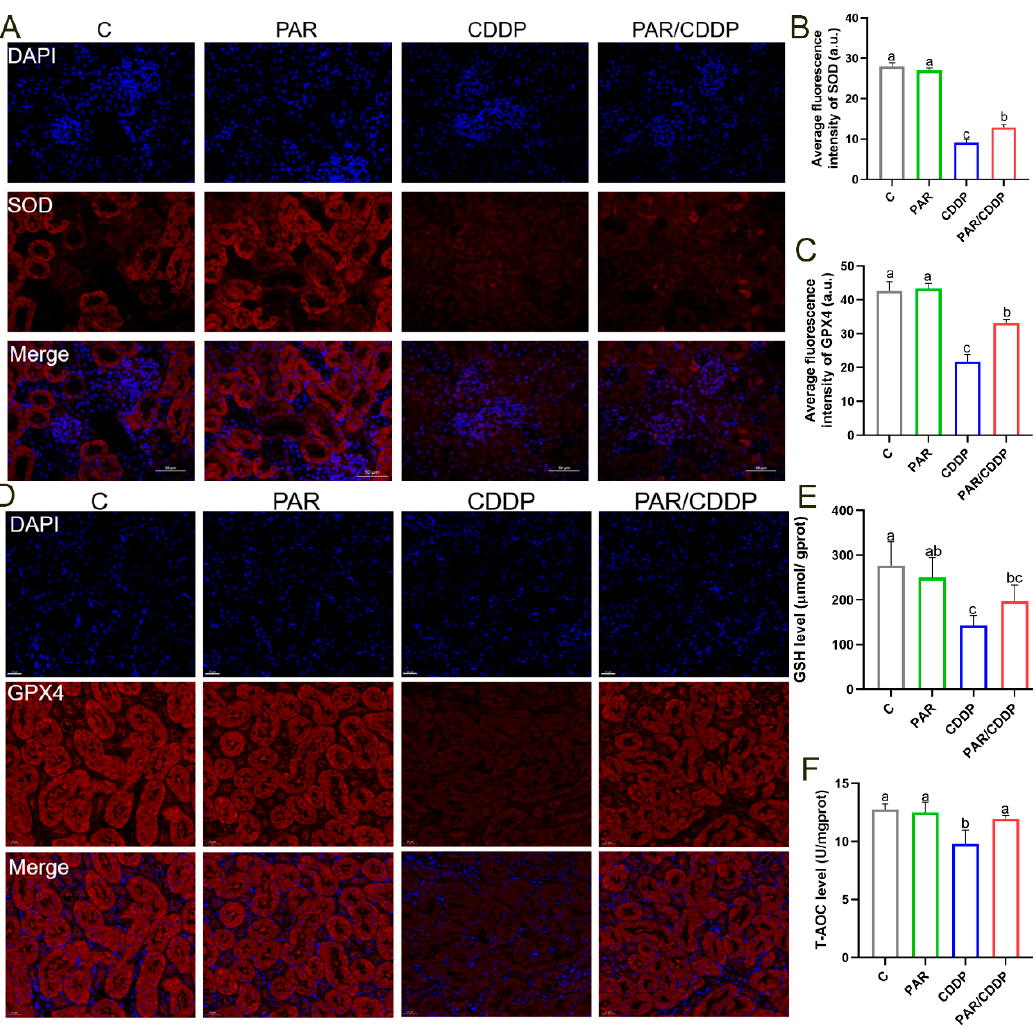
Figure 3. Effect of paricalcitol on anti-oxidant level of mice kidneys. ( A , B ) Representative images and quantification of SOD (red) detection by fluorescence microscopy (scale bars, 50 μ m; n = 3). ( C , D ) Representative images and quantification of GPX4 (red) detection by fluorescence microscopy (scale bars, 20 μ m; n = 3). ( E , F ) The levels of GSH and T-AOC in mice kidneys ( n = 6). C, control group; PAR, paricalcitol group; CDDP, cisplatin group; PAR/CDDP, paricalcitol + cisplatin group. Bars that do not share the same letters are significantly different ( p < 0.05) from each other. Results are presented as Mean ± SD. Statistical significance was obtained by one-way ANOVA.